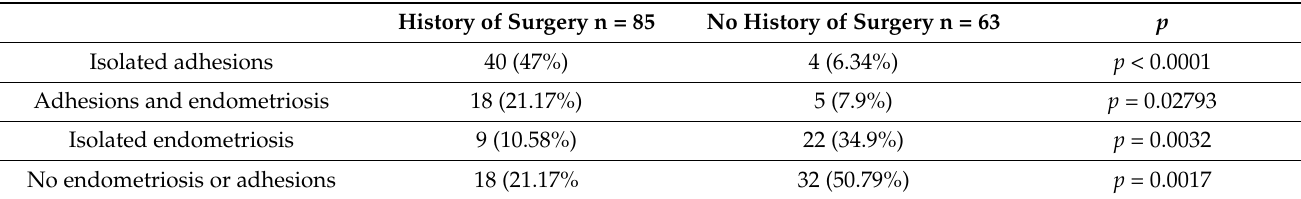
Table 1. Theresultsofthelaparoscopicexaminationinwomenwithchronicpelvicpainandsymptomssuggestiveofendometriosis.